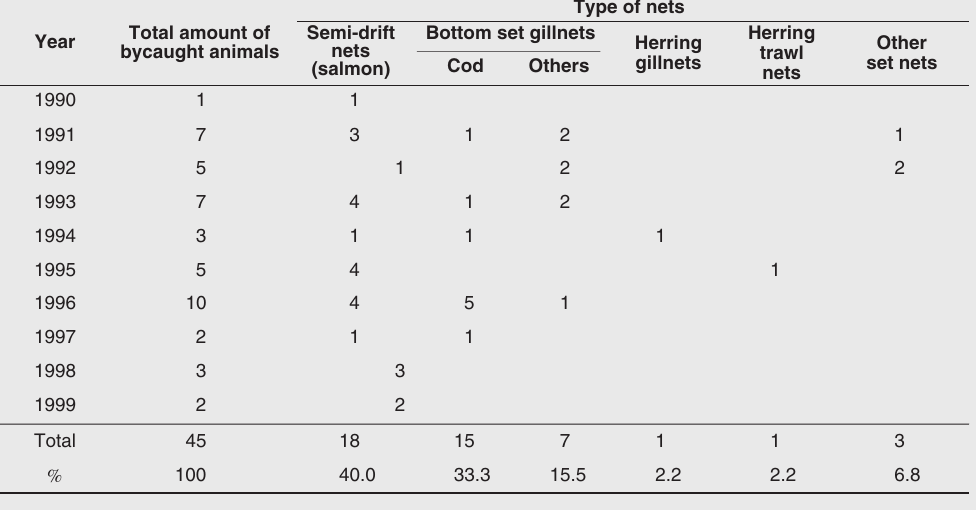
Table 2. Bycatches of harbour porpoises in various kinds of fishing nets during